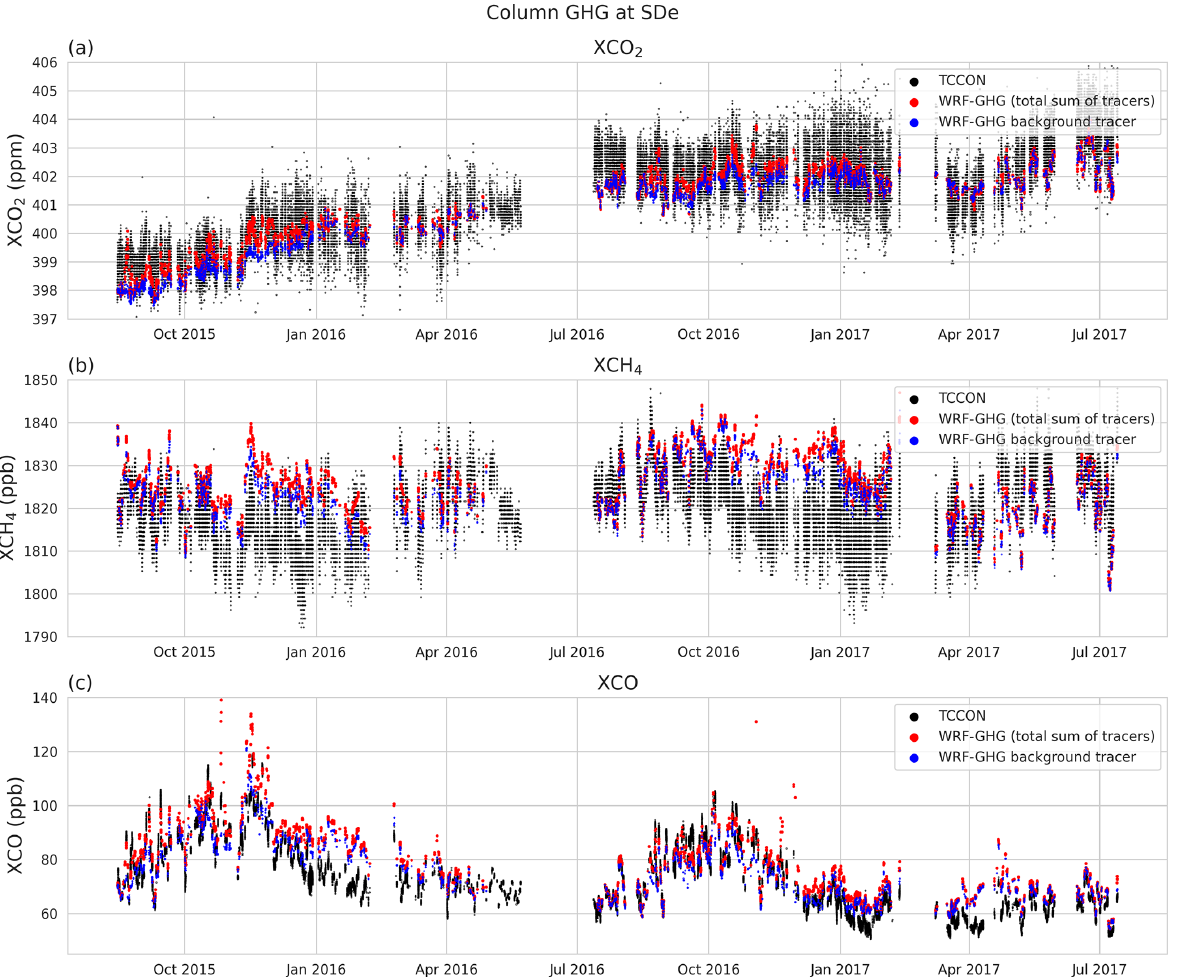
Figure C3. Time series of all observed (black) and modeled (red) column concentrations at SDe of (a) CO 2 , (b) CH 4 , and (c) CO. The blue dots represent the modeled background tracer. The modeled data are hourly and smoothed. The observed data are scaled to the atmospheric column until 50hPa, and all available measurements are